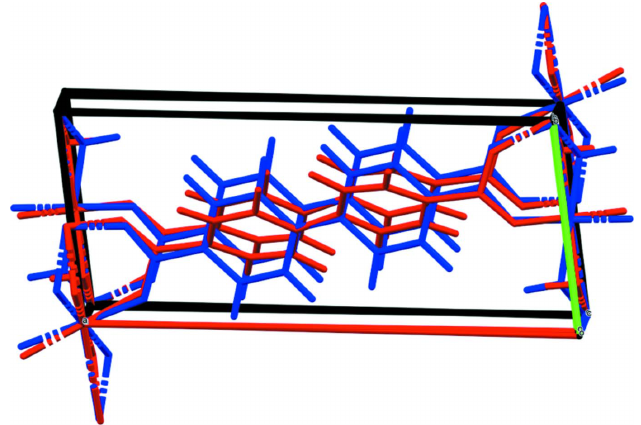
Figure 6 Comparison of the Rietveld-refined (red) and VASP -optimized (blue) structures of Ni 2 (BPDC)(OH) 2 . The r.m.s. Cartesian displacement is 0.563 A˚ . Image generated using Mercury (Macrae et al. , 2020).